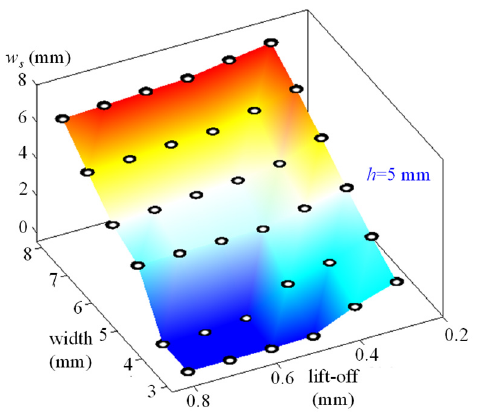
Figure 15. Values of w s